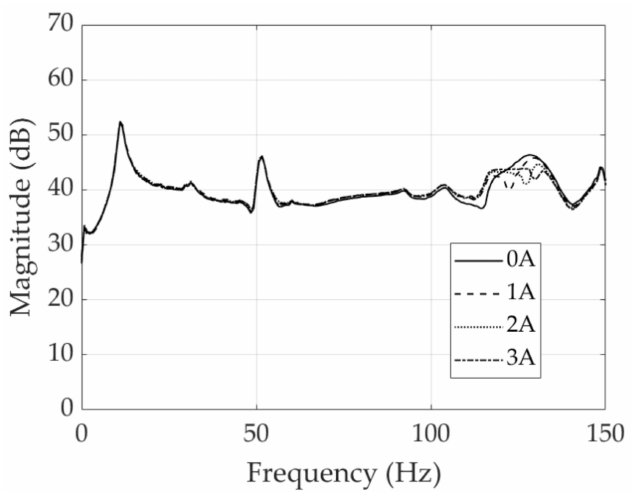
Figure 22. Vibration reduction results of adaptive tuned MRE vibration absorber by frequency-variable excitation [current: 0, 1, 2, 3A].